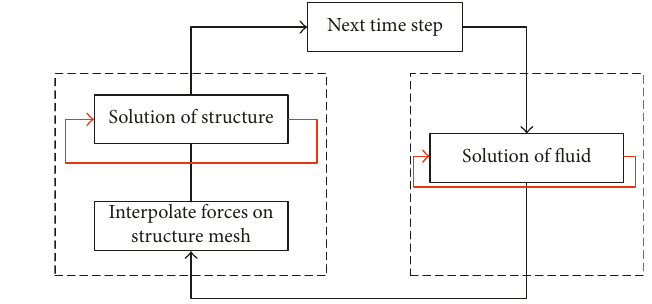
Figure 1: One-way coupling solution.